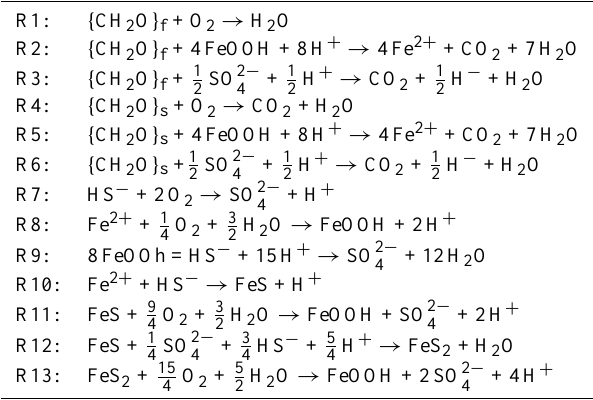
Table 1. Kinetic reactions included in the reaction